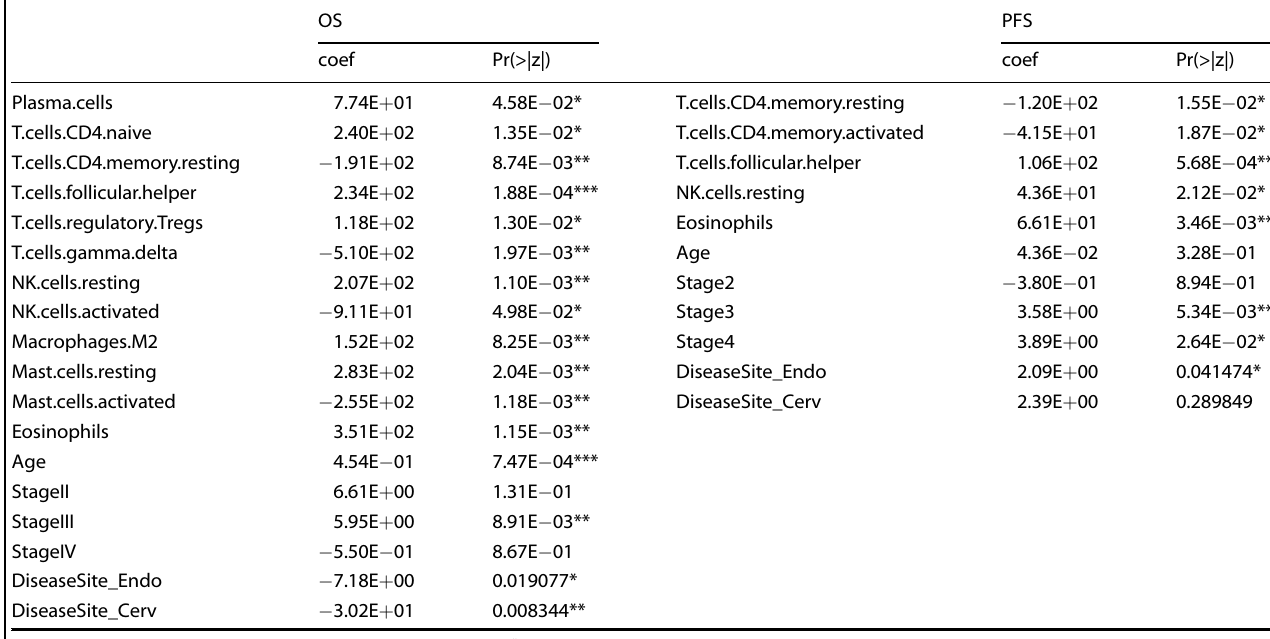
Table 4. Multi-variate analysis for OS and PFS with LM22 in entire cohort, with age, clinical stage, and disease site as co-variates. OS